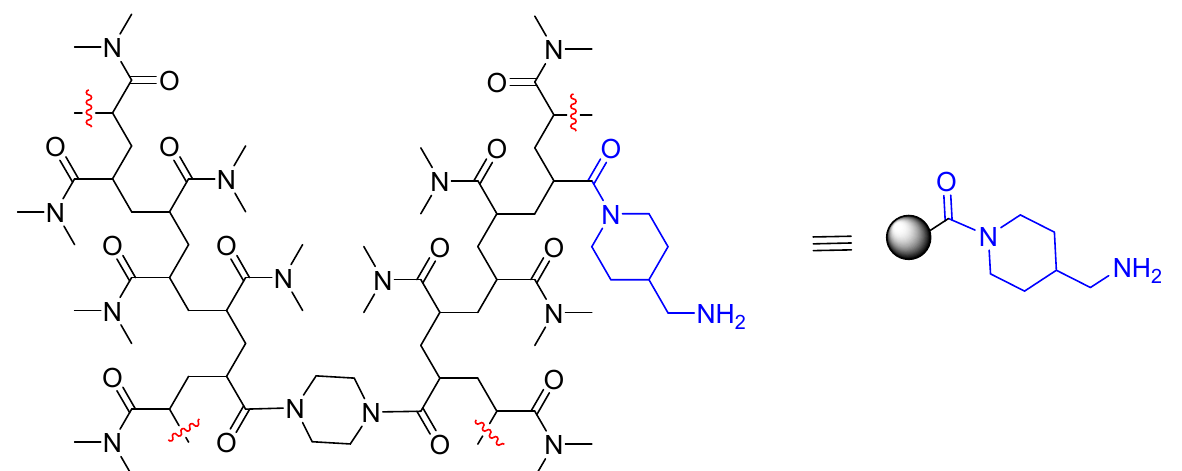
Figure 1. Chemical structure of amino-Li-resin prepared from N,N-dimethylacrylamide as a monomer, N,N’-bis(acryloyl)piperazine as cross-linker, 1-[1-(N-acrylyl)piperidin-4-yl]methanamine as functionalizing moiety, and N,N,N’,N’-tetramethylethylenediamine as initiator. 4-(aminomethyl)piperidin-1-yl functionalization, an aliphatic amine, is more reactive than